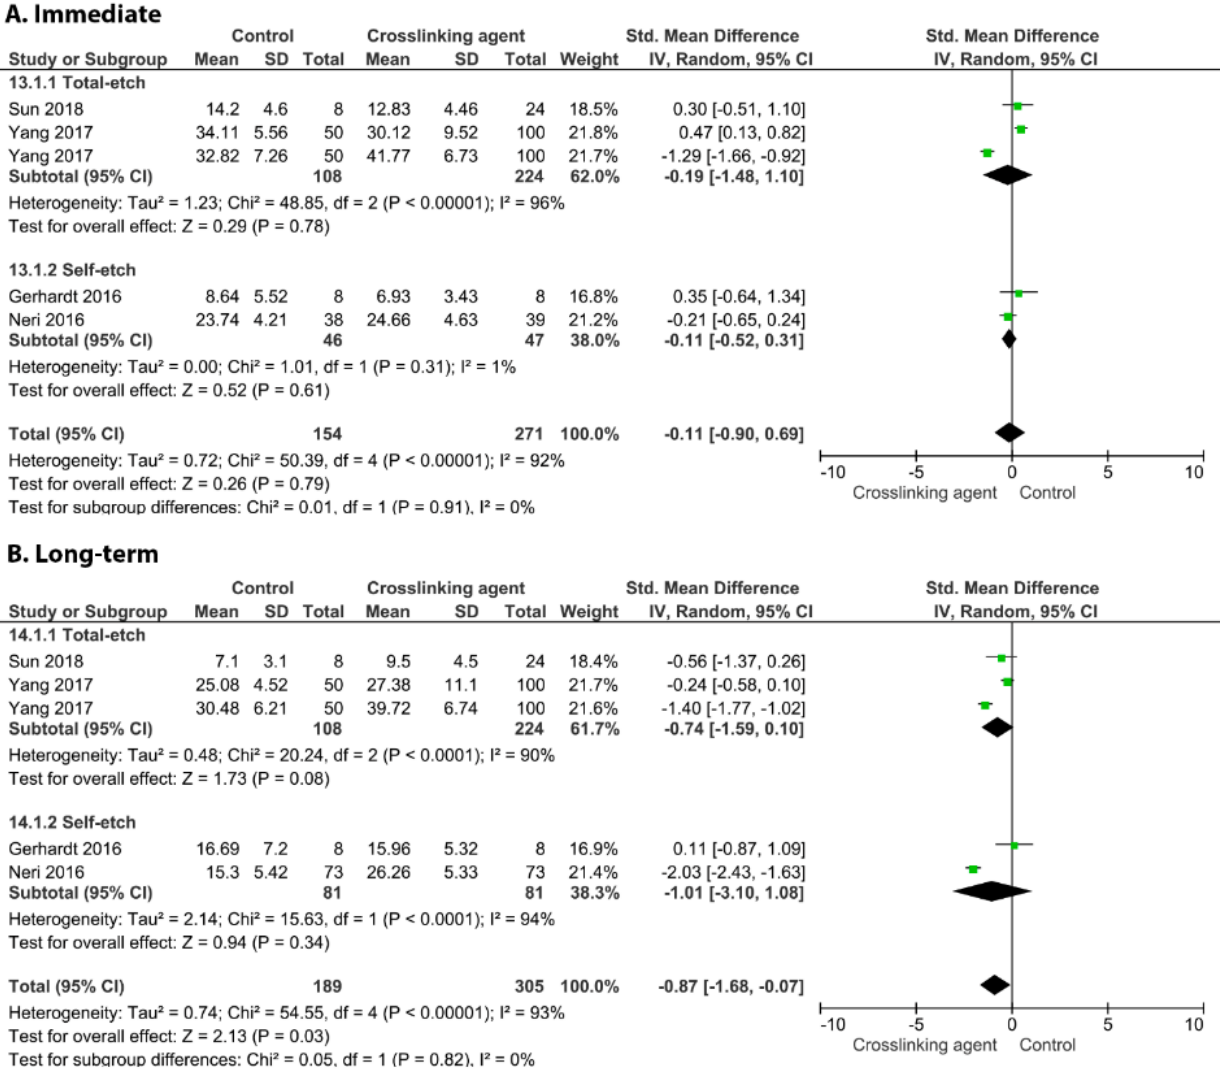
Figure 3. Forest plot of the immediate ( A ) and long-term ( B ) bond strength comparison between the EGCG crosslinking agent and the control according to the adhesive used, [67,86,95,119].